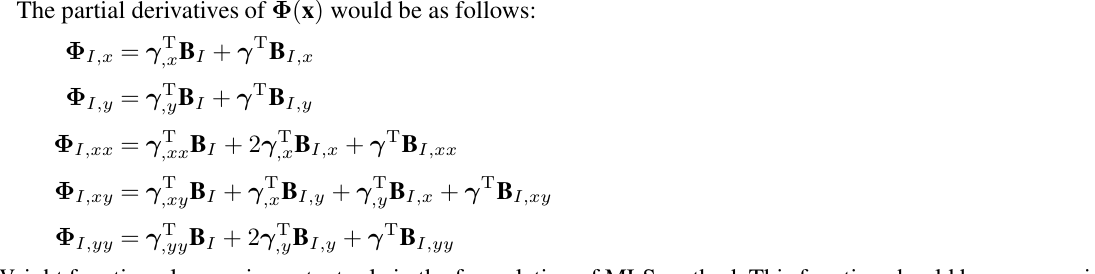
Dimensionless parameter of natural frequencies, ¯ ω = ωa